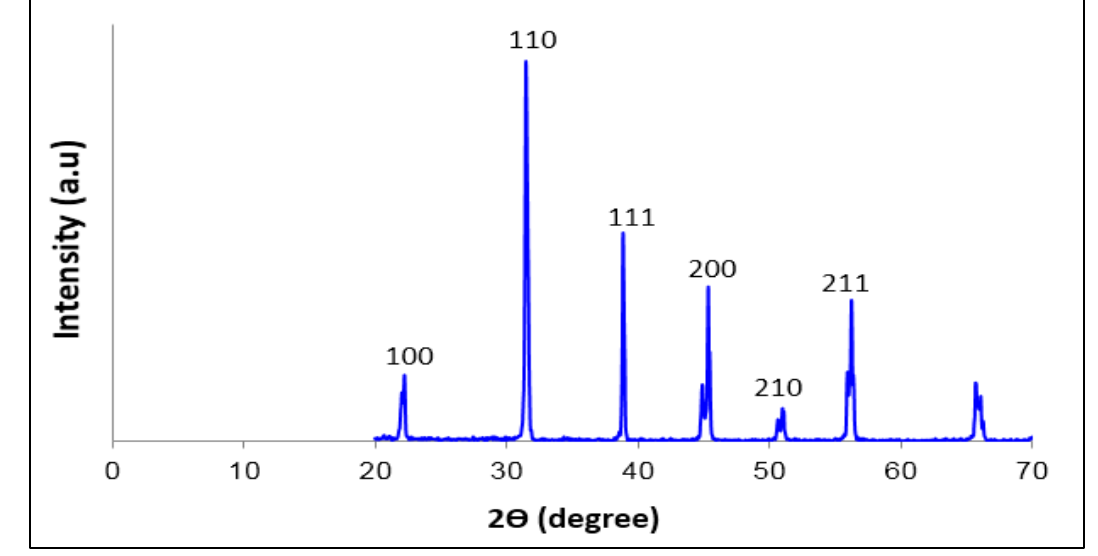
Figure 10: Micro Barium Titanate XRD pattern at 1350 ° C.